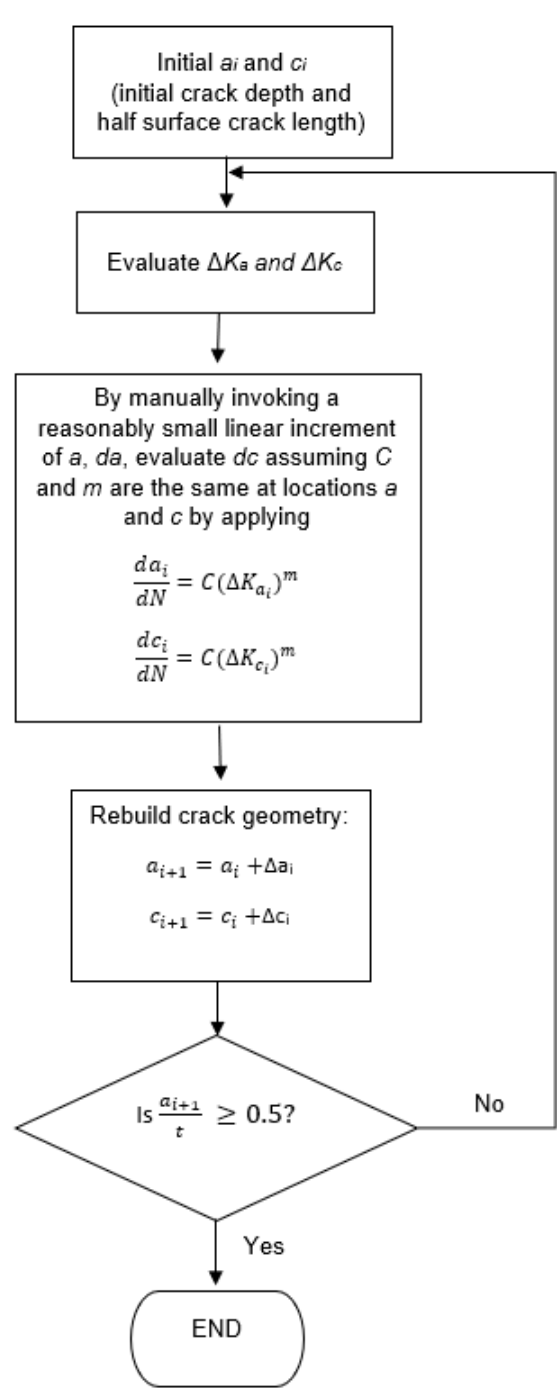
Figure 17. Procedure for evaluating change crack aspect ratio and crack growth.